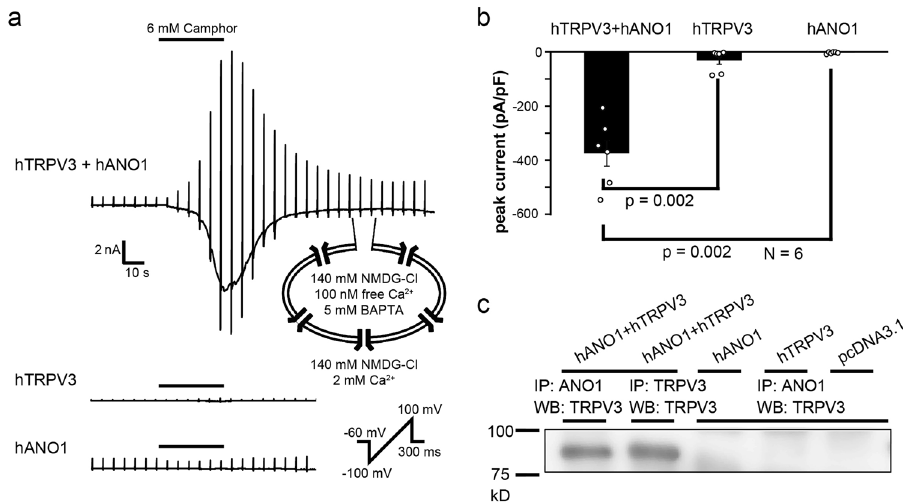
Fig. 2 TRPV3 and ANO1 interaction in HEK293T cells. a A representative trace of the camphor-induced currents in HEK293T cells expressing both hTRPV3 and hANO1, hANO1 alone or hTRPV3 alone. All data were collected using an NMDG-Cl bath and pipette solutions. Free calcium in the pipette solution was 100 nM. The holding potential was − 60 mV and ramp-pulses were applied from − 100 to + 100 mV for 300 ms duration every 5 s. b Comparison of peak currents of (A) at − 60 mV (means ± SEM, N = 6). Statistical signi fi cance was determined with a Mann – Whitney test. c Immunoprecipitation of ANO1 or TRPV3 and Western blot of TRPV3 in HEK293T cells transfected with TRPV3 and ANO1 cDNAs, Ano1 alone, TRPV4 alone or pcDNA3.1. Uncropped gel images are shown in Suppl. Fig.